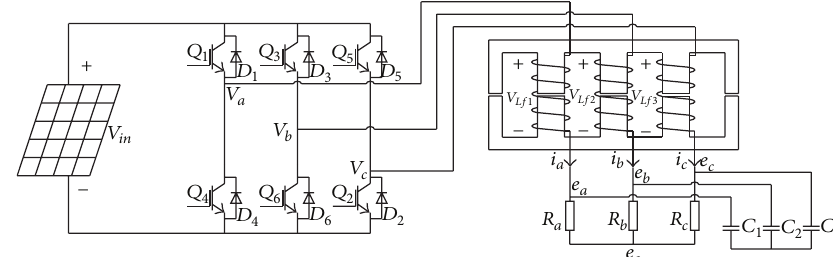
Figure 4: The three-phase integrated filter inductors with five magnetic limbs in three-phase inverter.